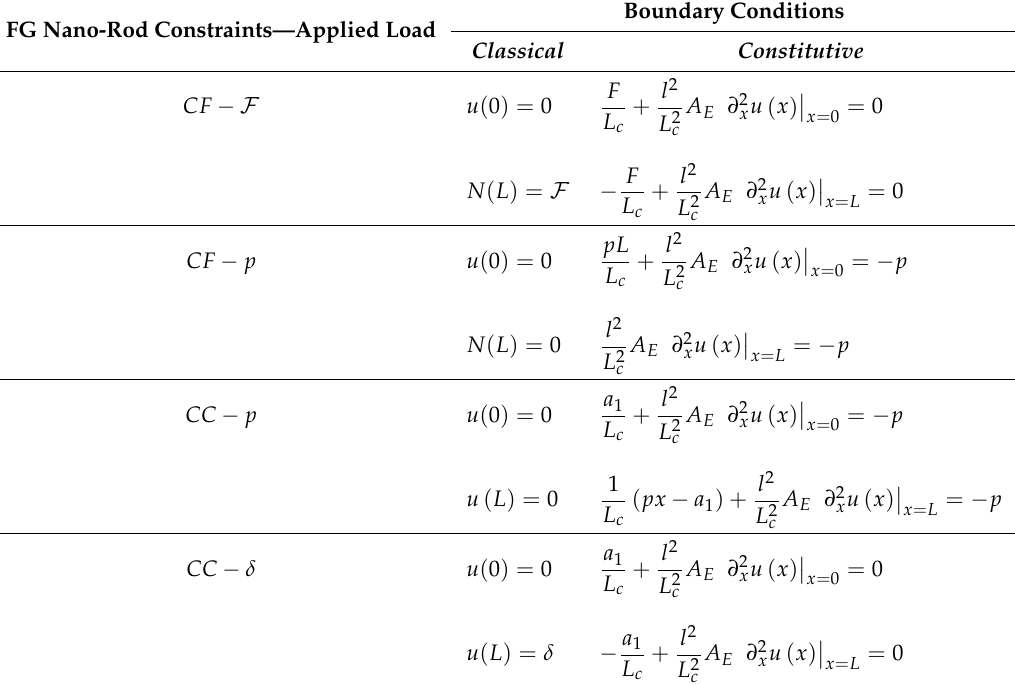
Table 1. Fundamental schemes with corresponding boundary